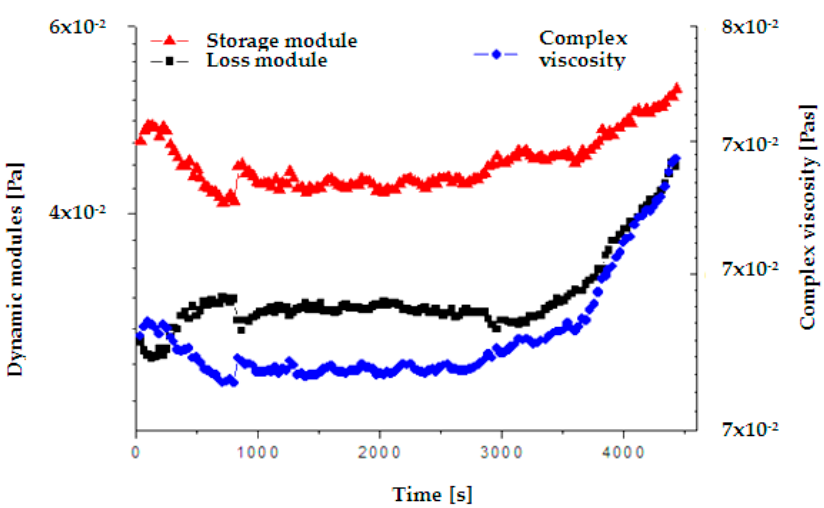
Figure 10. Storage module, loss module and complex viscosity for EM_4a, measured 24 h from manufacturing.